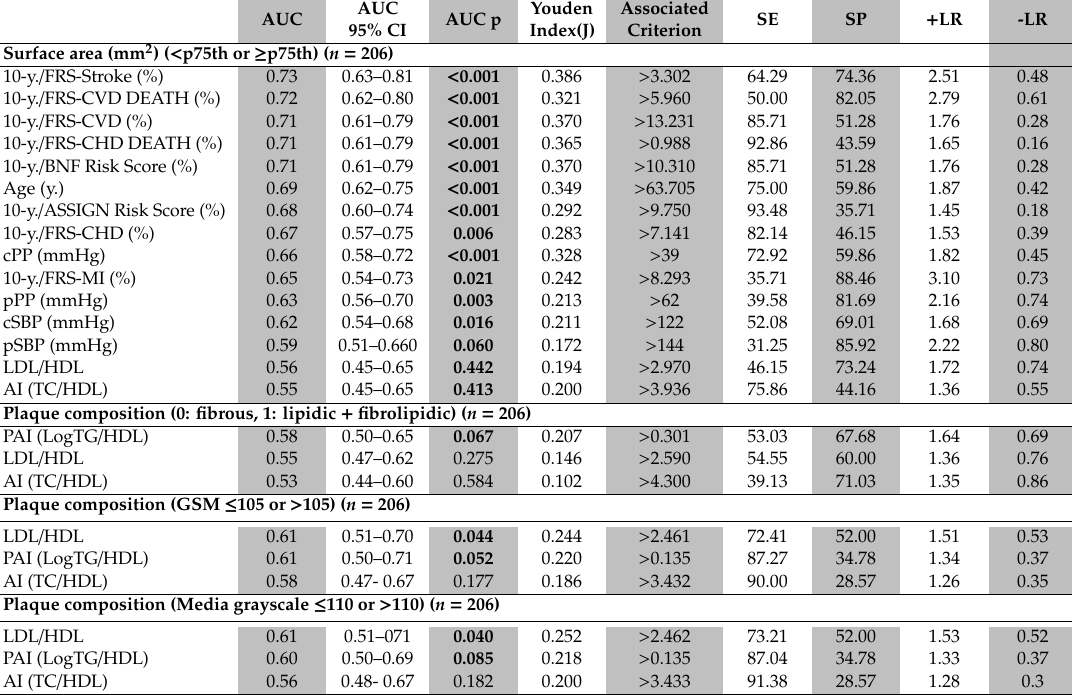
Table 5. Plaques geometry and composition detection: ROC curves-derived parameters. AUC Youden Associated AUC AUC p SE SP + LR -LR 95% CI Index(J) Criterion Surface area (mm 2 ) ( < p75th or ≥ p75th) ( n = 206) 10-y. / FRS-Stroke (%) 0.73 0.63–0.81 < 0.001 < 0.001 0.370 > 13.231 85.71 51.28 1.76 0.28 10-y. / FRS-CHD DEATH (%)